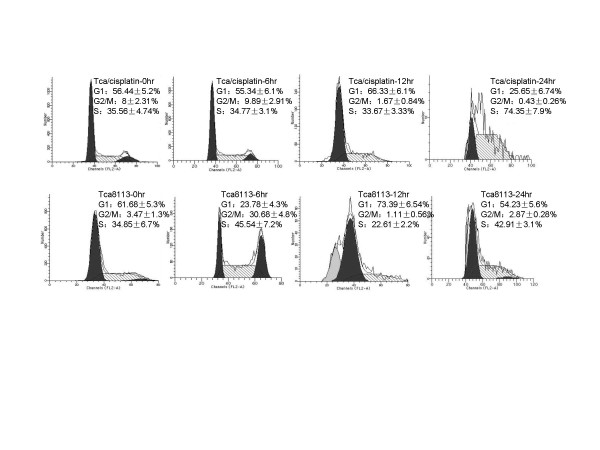
Effects of 10 μM cisplatin on Tca/cisplatin and Tca8113 cell cycle distribution. After exposure to 10 μM cisplatin for 0, 6, 12 and 24 h, cells were harvested and stained with propidium iodide to assess cell cycle distribution by FACS analysis. Representative time course for Tca/cisplatin and Tca8113 cells in different phases of the cell cycle (one time course each) are shown. The results are expressed as mean ± SD of three independent experiments. A predominant S phase block of 74.35% was observed at 24 h in the Tca/cisplatin cells, significantly higher than the 42.91% in the Tca8113 cells.